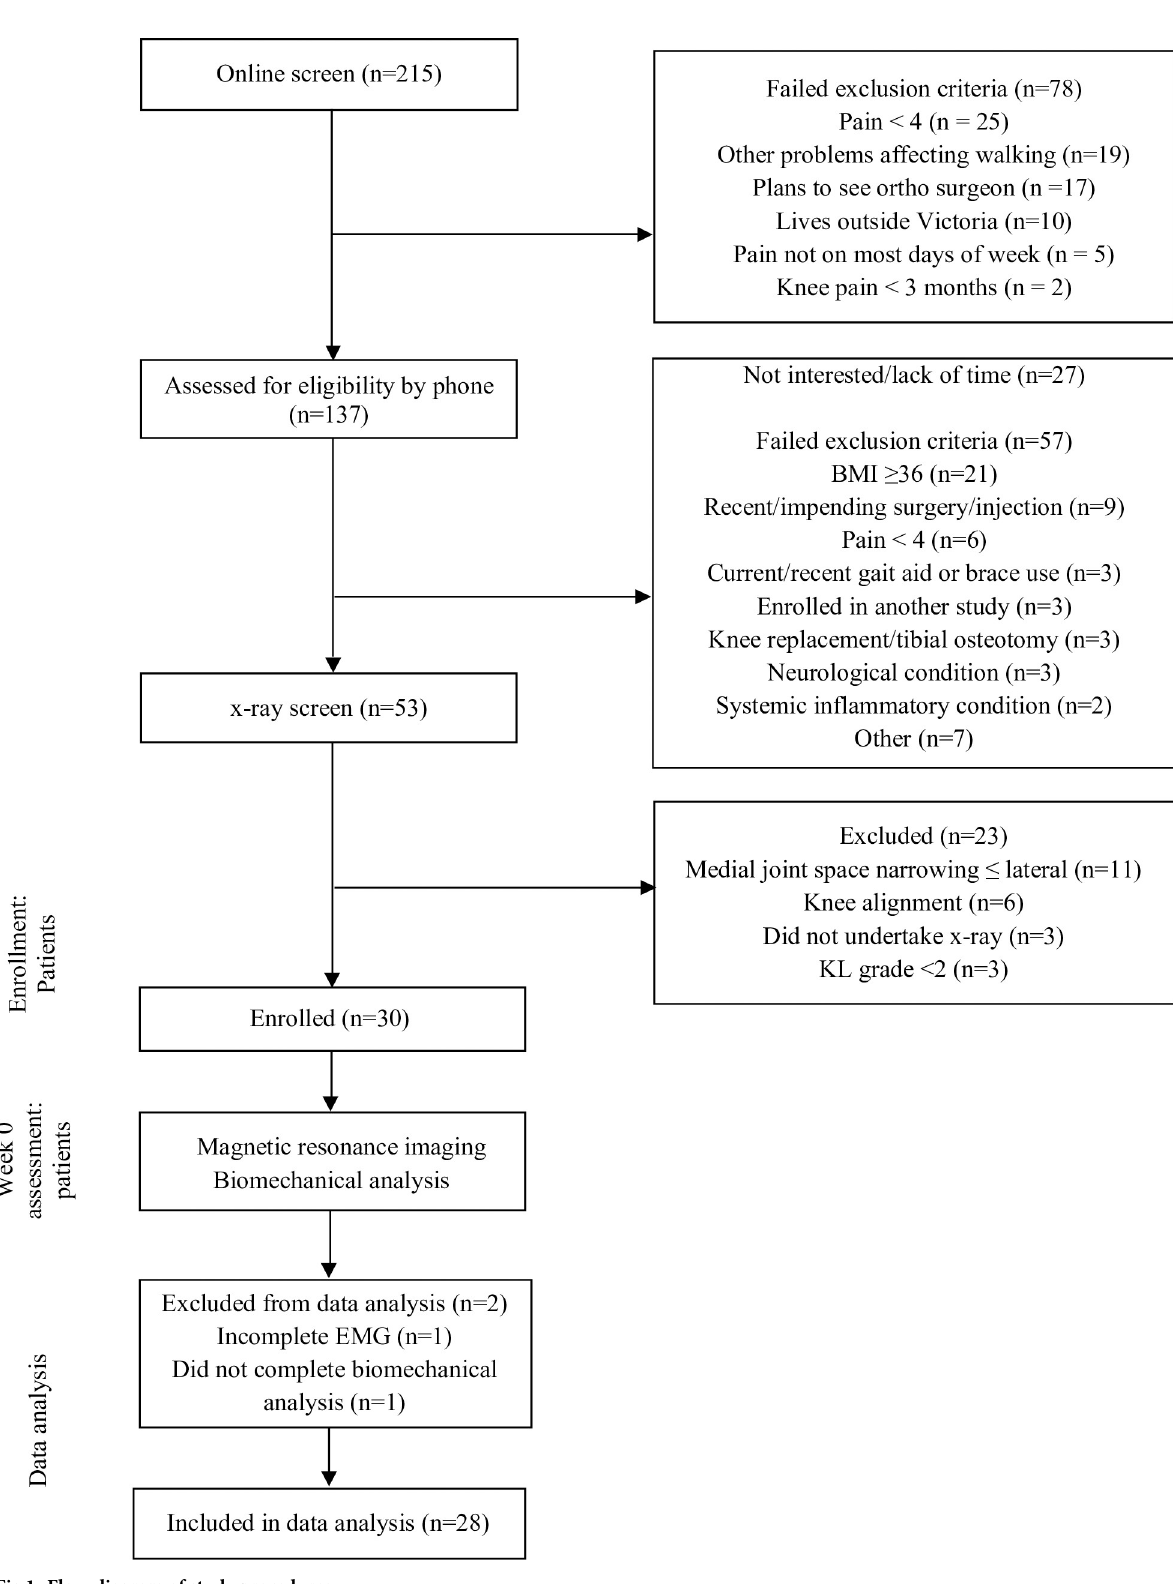
PLOS ONE | https://doi.org/10.1371/journal.pone.0269331 June 2,